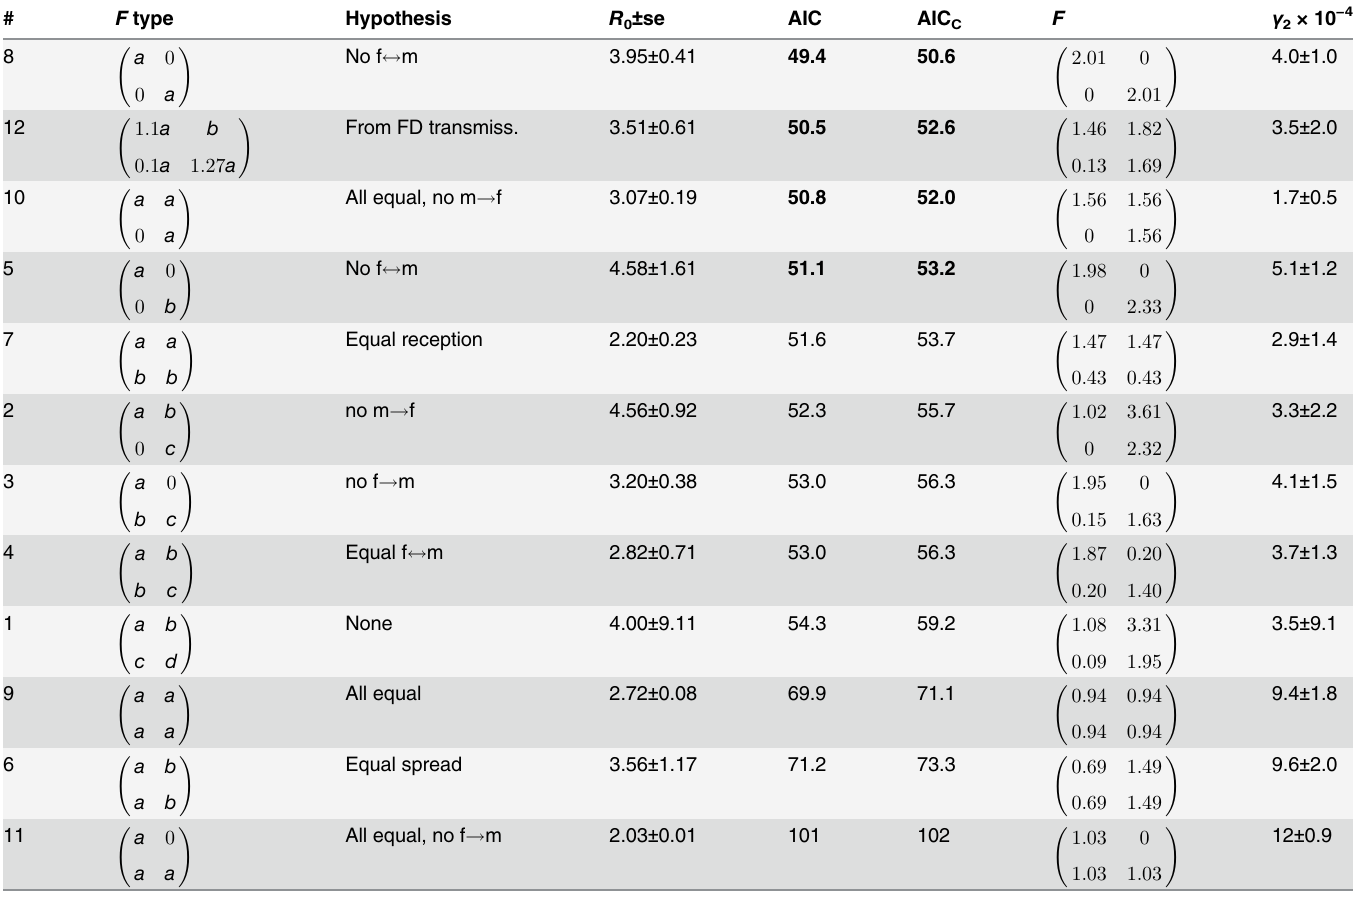
Table 4. Testing hypotheses on the details of disease transmission (structure of the matrix F in Eqs (12) and (13)). Hypotheses with Δ AIC < 2 are marked with bold font. The same four models have the lowest AIC C as